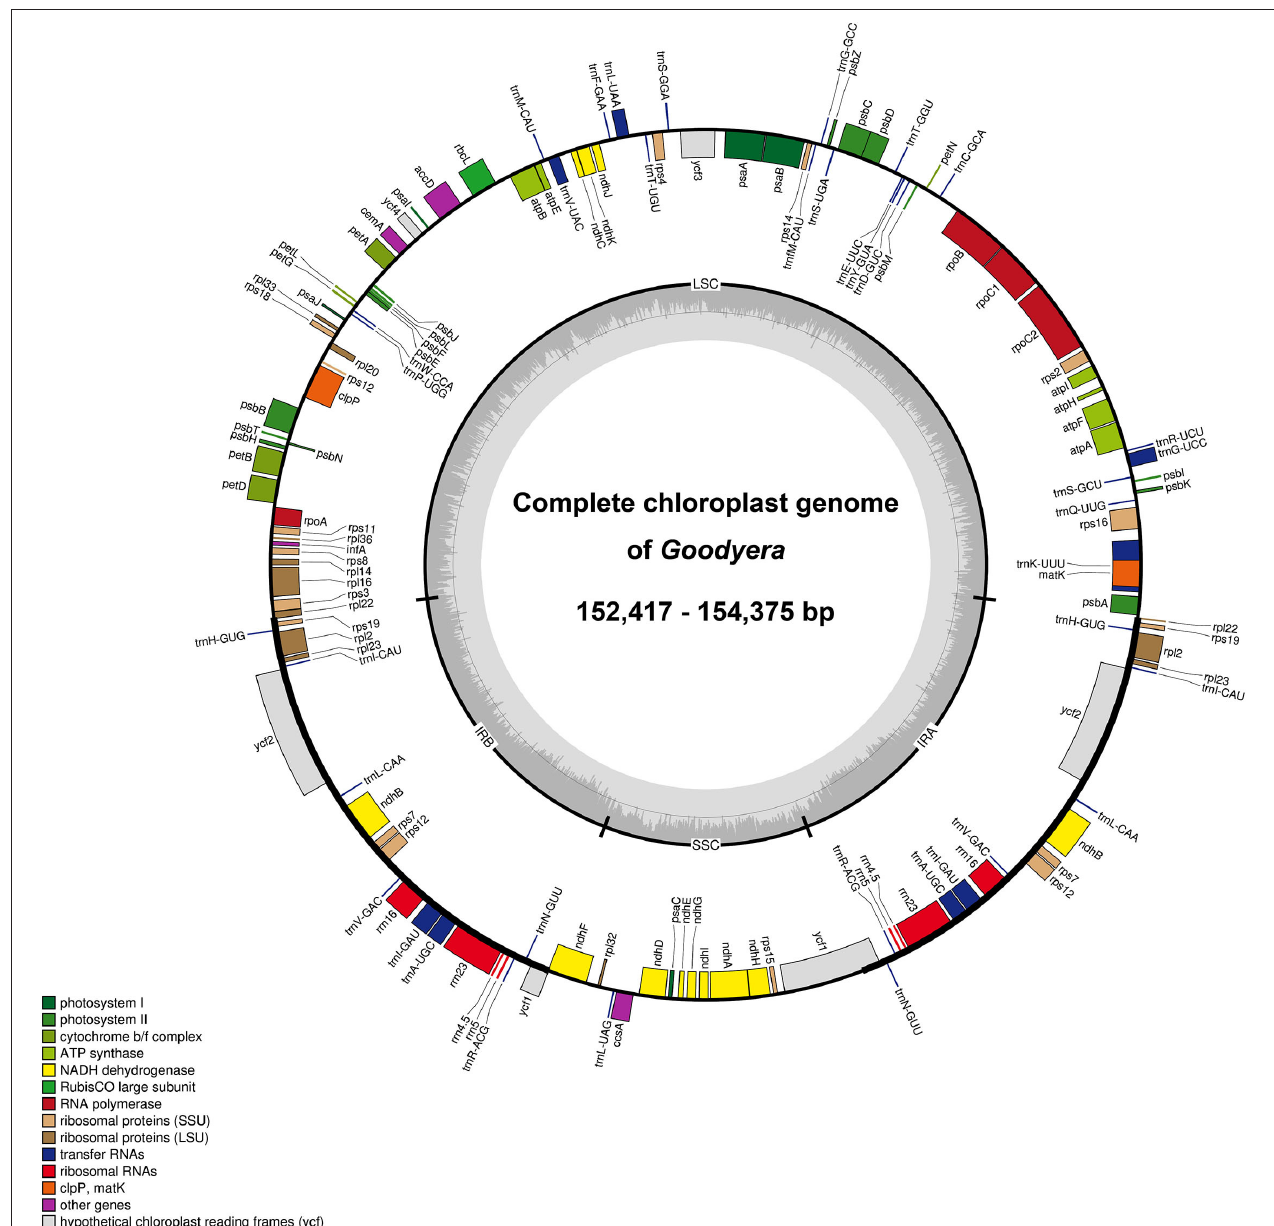
FIGURE 1 | Representative plastid genome of Goodyera. The colored boxes represent functional groups of plastid-coding genes. Genes shown inside the circle are transcribed clockwise, whereas genes shown outside the circle are transcribed counter-clockwise. The small gray bar graphs in the inner circle show the GC